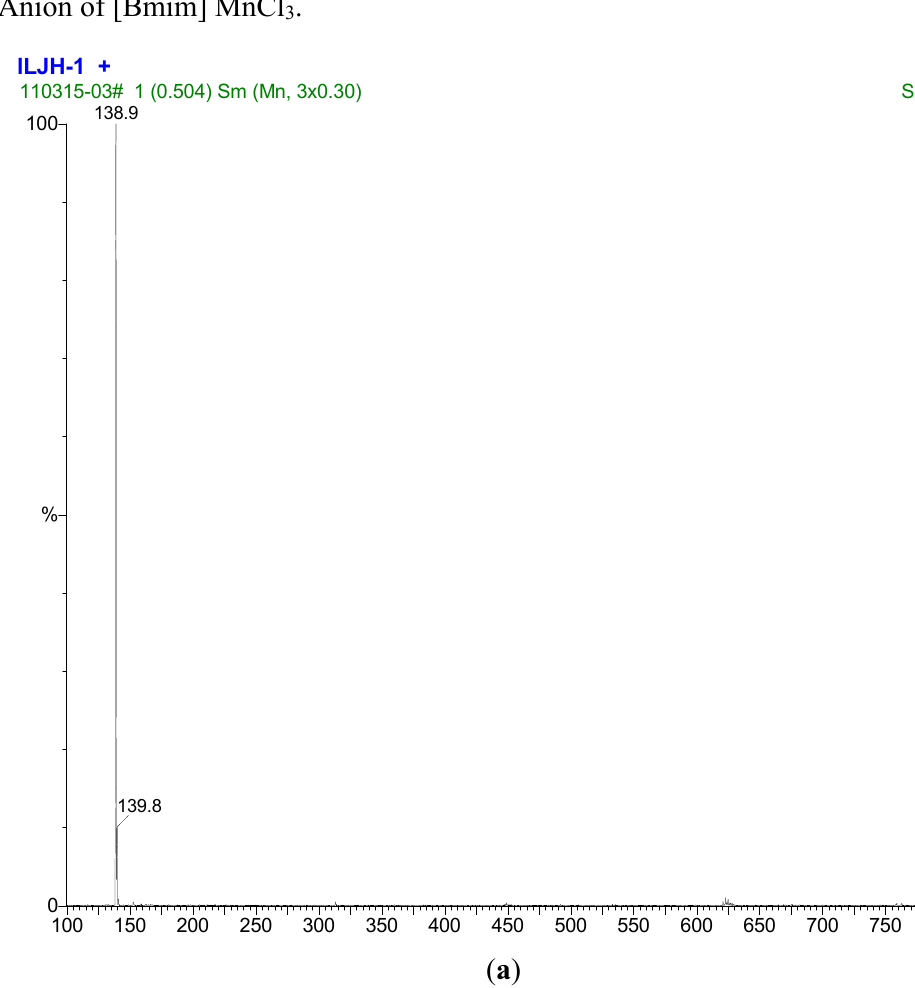
; ( b ) Anion of [Bmim]ZnCl 3 3